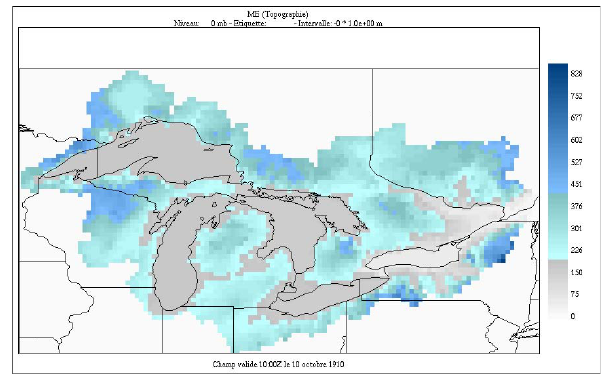
Fig. 4. Topography of the basin at 1/6th of a